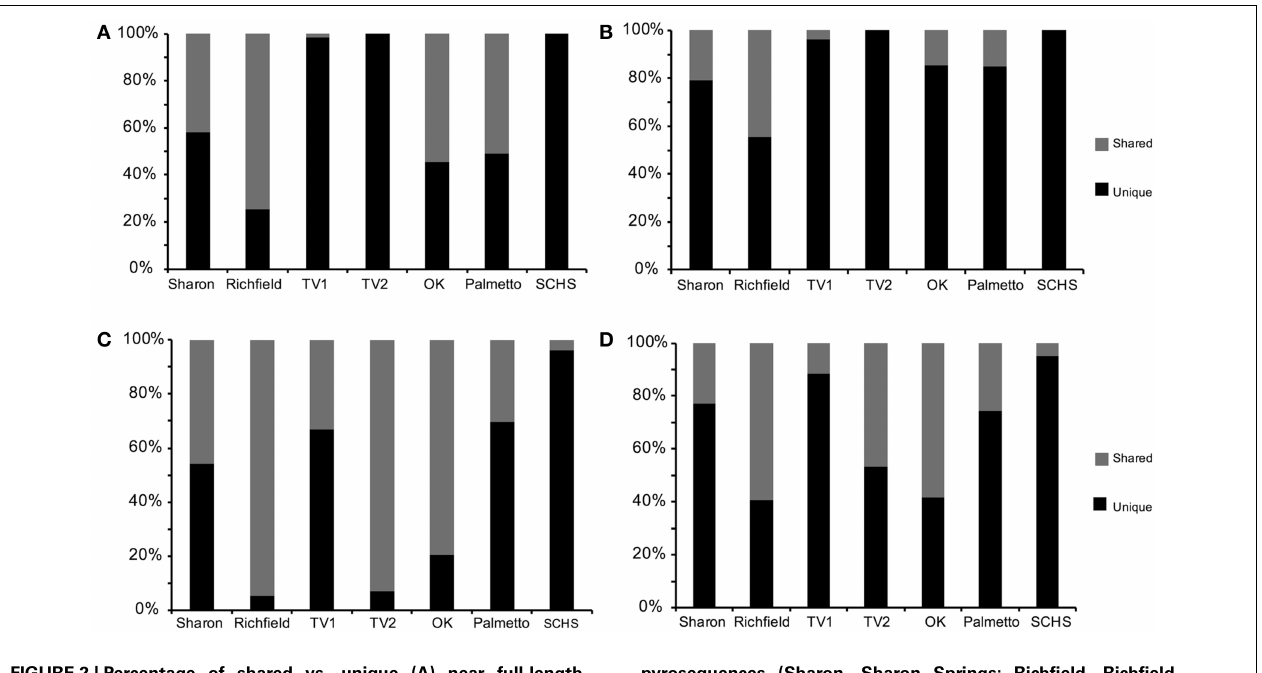
FIGURE 2 | Percentage of shared vs. unique (A) near full-length 16S rRNA gene sequences from Sanger sequencing and (B) operational taxonomic units (OTUs) from Sanger sequences, and (C) pyrosequences of 16S rRNA genes and (D) OTUs